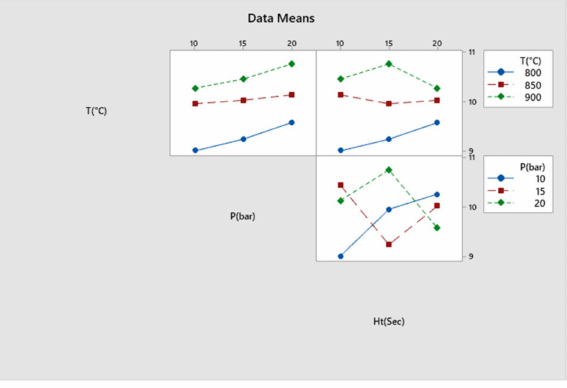
Figure 11. Interaction plots for